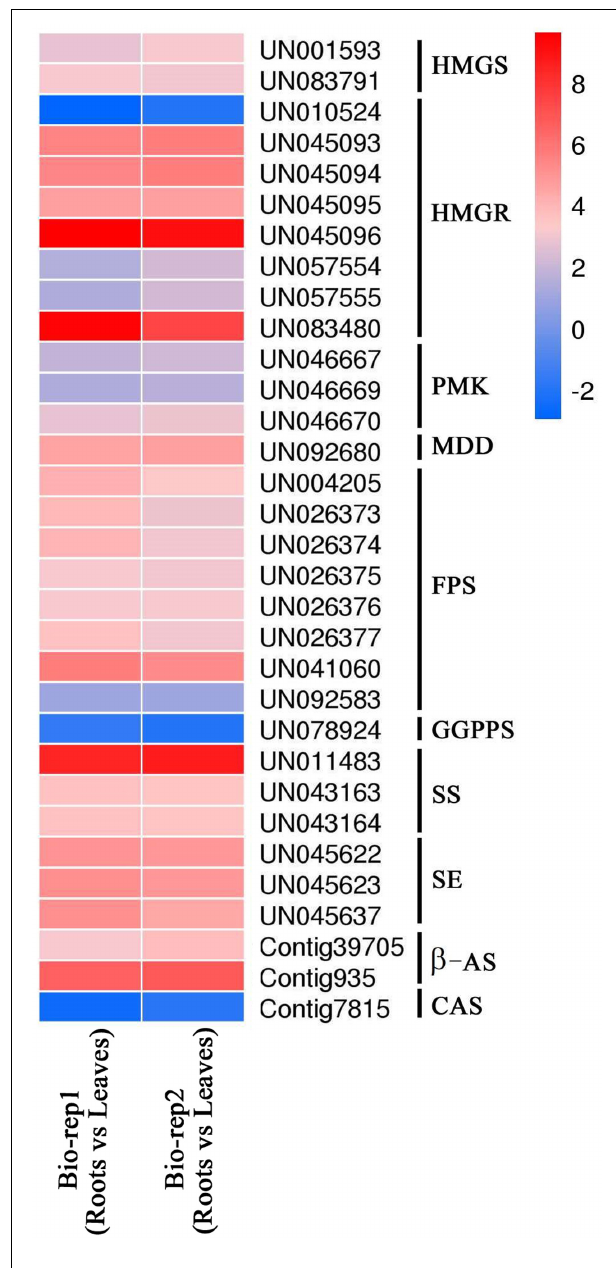
FIGURE 8 | Expression profile for the candidate unigenes from teiterpenoid saponins biosynthetic pathways across two tissues. The bar represents the scale of the expression levels for each gene of roots vs. leaves as indicated by red/blue rectangles. Red indicates up-regulation of genes and blue indicates down-regulation of genes. Expression ratios are expressed as log2Fold Change